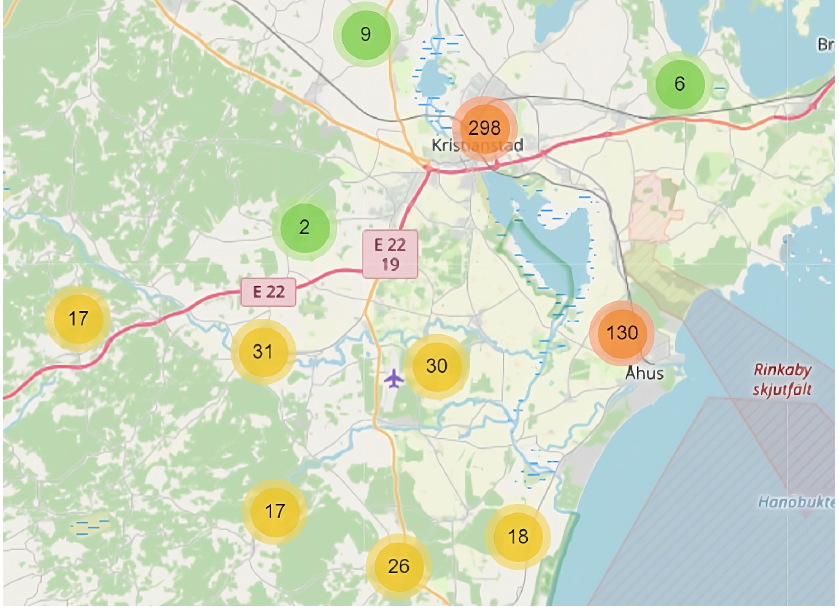
Figure 1. A graph that shows how sensors are deployed in Kristianstad. The graph is taken from the IoT portal of Kristianstad Municipality. Permission to publish is acquired from Kristianstad